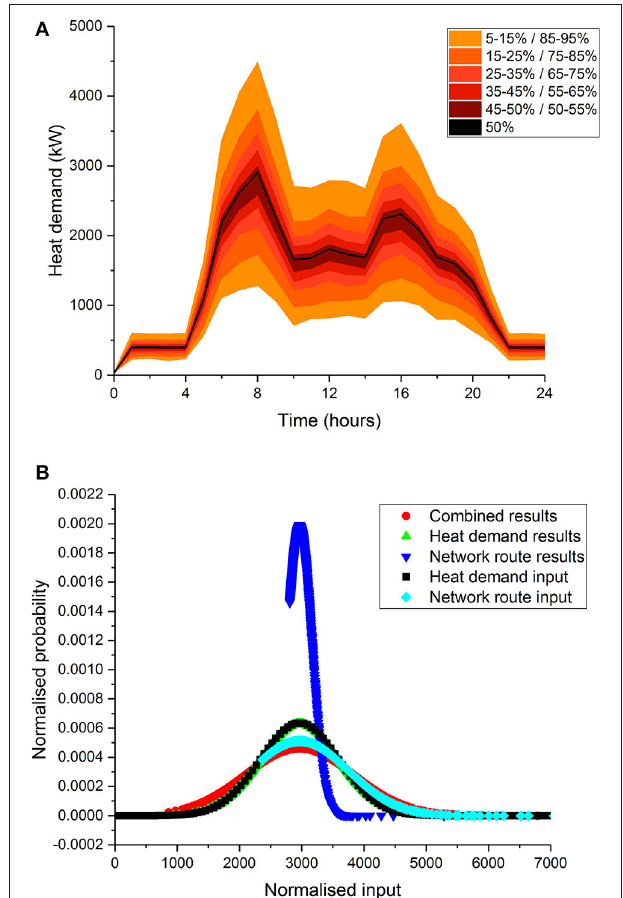
FIGURE 7 | (A) Results of the global Monte Carlo Simulations for the assumption of standard heat demand profiles (2) and network route length (3) after 1,000 simulations. The mean result, 50th percentile, is shown with a black line. The range of percentiles to the extremes of 5th and 95th are denoted by the color bands. (B) The distribution of the heat demand from the global and individual Monte Carlo simulations as well as the distributions of heat demand and network route length as found in the